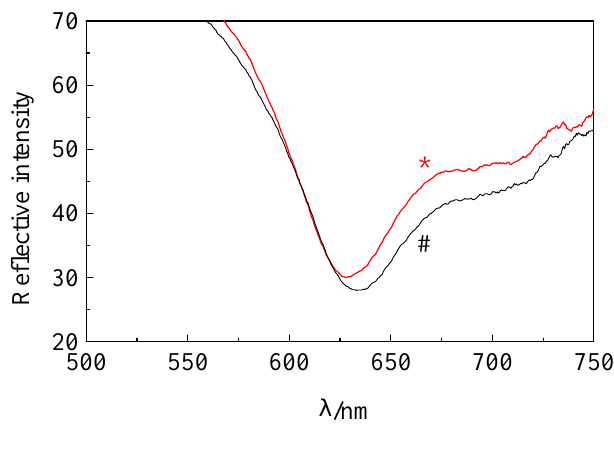
Figure 3. Resonant wavelength shift versus immobilization time of biotinylated anti-rabbit IgG onto an avidin-modified surface of SPR sensor: * Avidin, #. biotinylated anti-rabbit